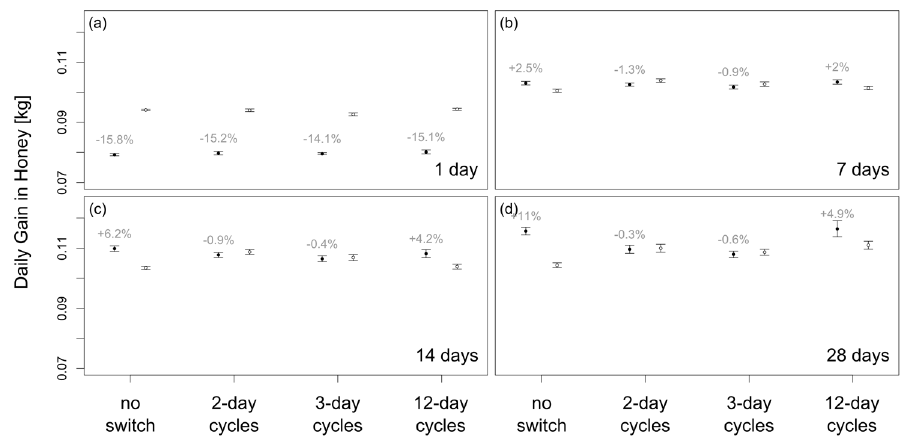
Figure 2. A comparison of foraging success measured as mean daily gain in honey (means ± s.e.) under varying patch longevities and with various intervals between experimental switches of spatial information transfer (SI) and no spatial information transfer (NI) treatments (no switches, 2-day cycles, 3-day cycles, 12-day cycles). The benefit of SI varies with patch longevity, with increasing benefits from one day (a), 7 days (b), 14 days (c), to 28 days (d). SI is more beneficial, if patches are relatively stable over time. Switching between SI and NI treatment hides the benefit of SI to a large degree (solid circle: SI, open circles: NI).